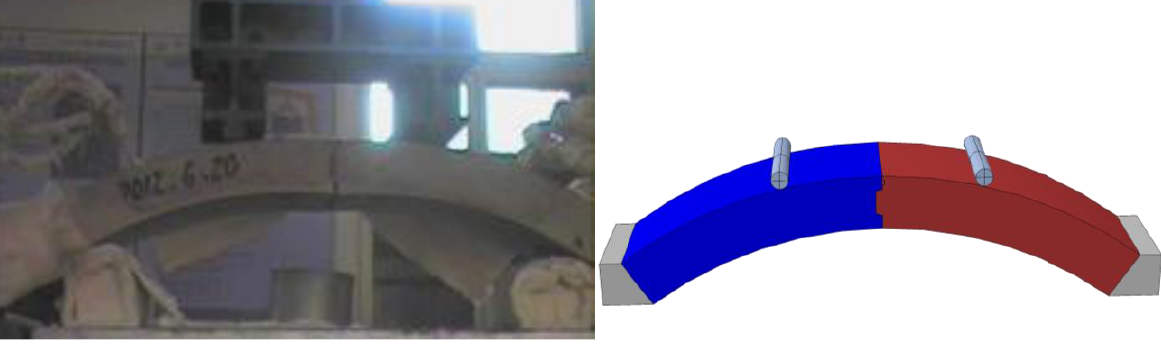
Figure 5. Comparison of the analytical model and experiments [14].